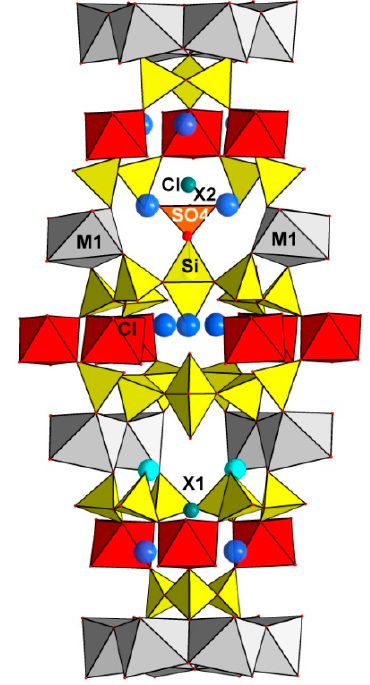
Figure 13. The crystal structure of aqualite viewed along (210).